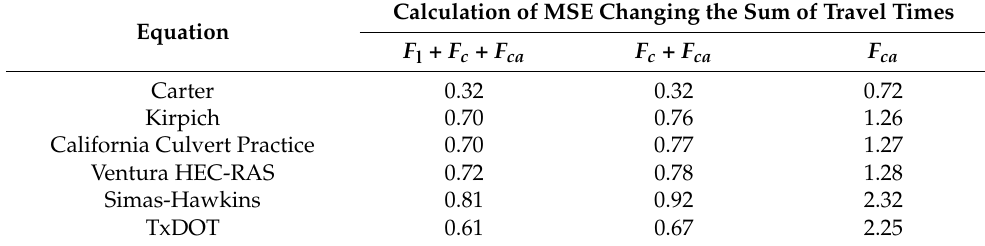
Table 10. Calculation of MSE to assess the sensitivity of the sum of travel